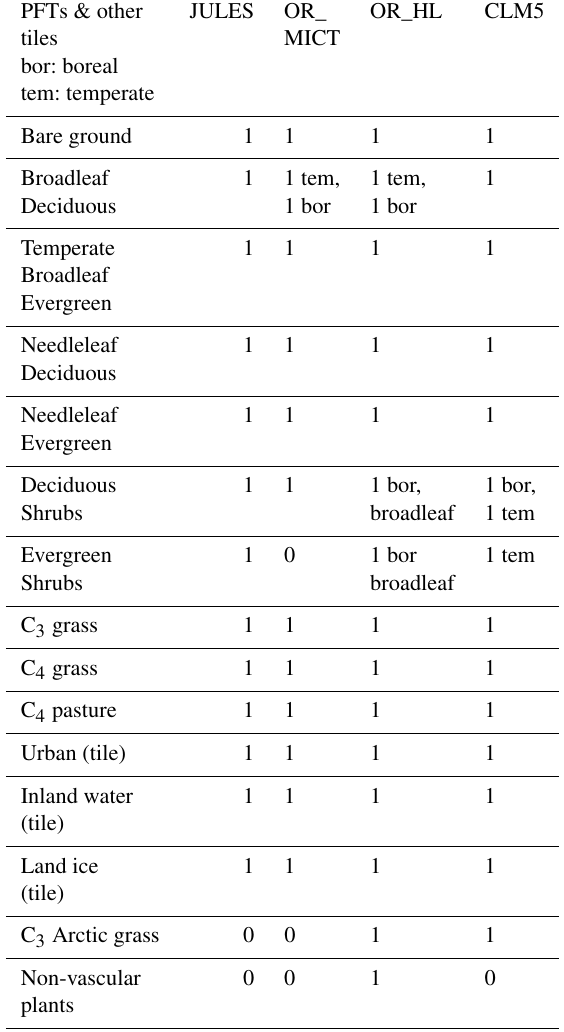
Table C1. Table of plant functional types relevant in high-latitude calculations for each